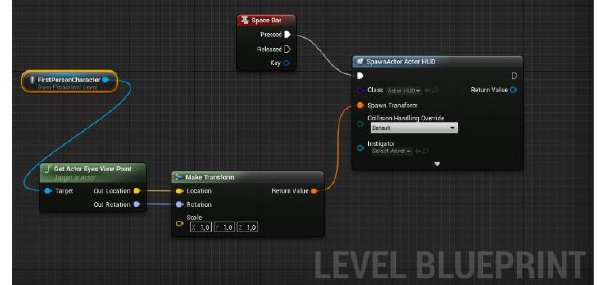
Figure 5. Sample blueprint responsible for showing user interface element on space bar key pressing action.